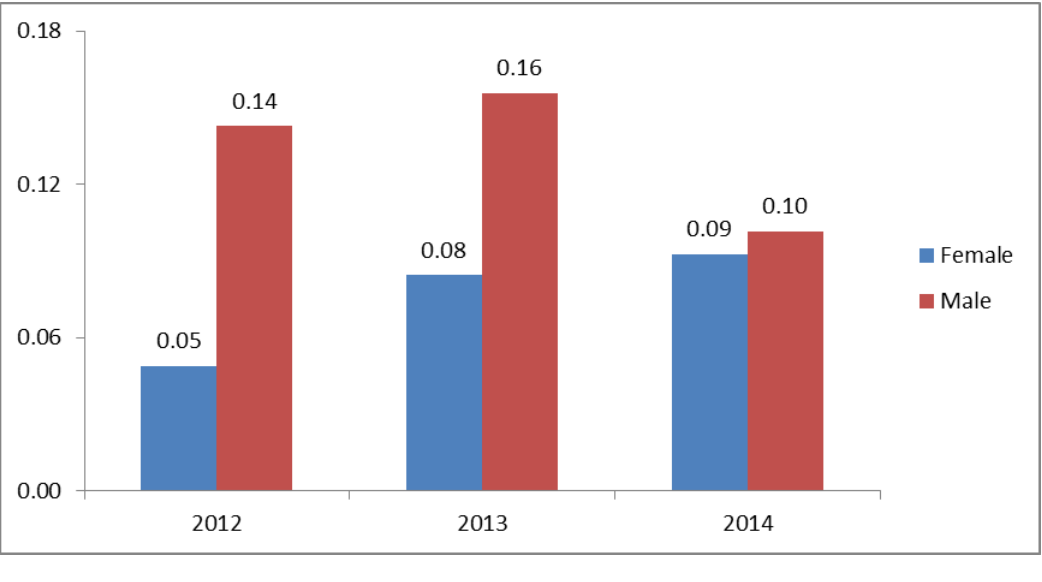
Figure 1. Crude incidence of primary sclerosing cholangitis per 100,000 individuals in the years 2012–2014 stratified by gender.